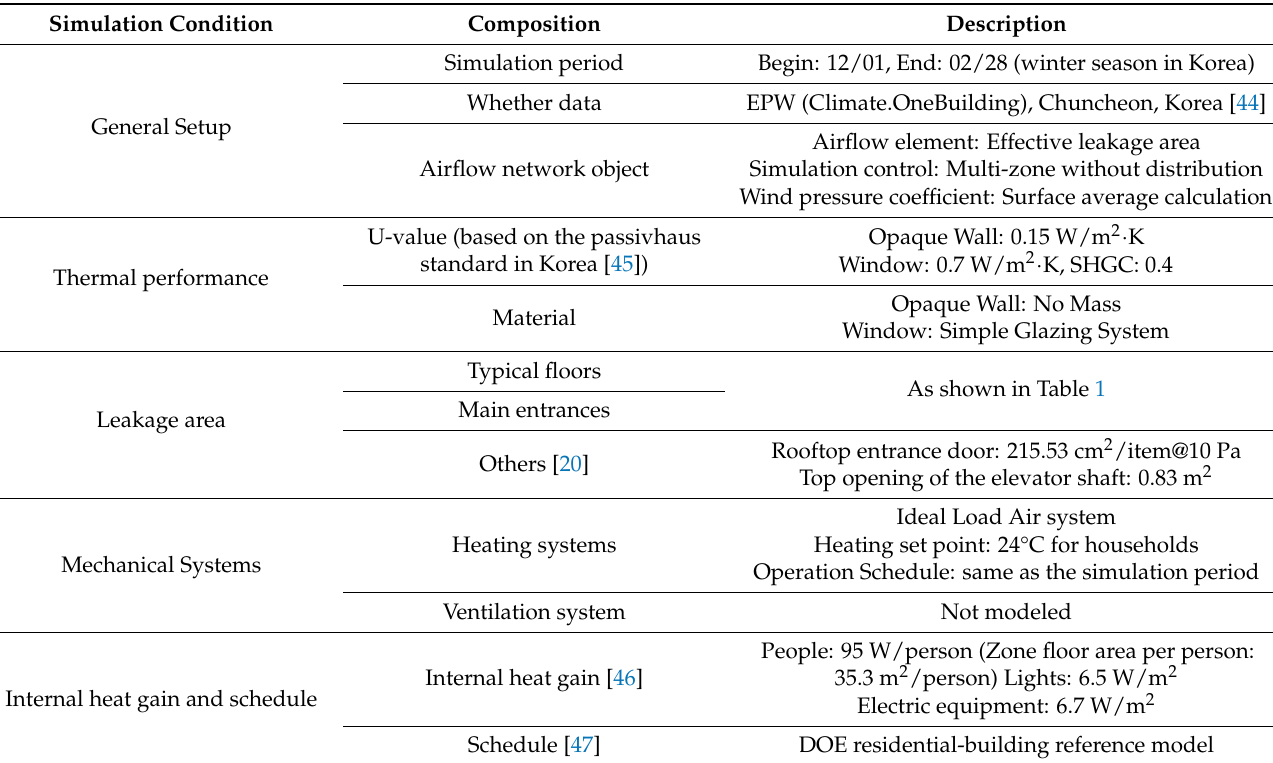
Table A2. EnergyPlus simulation conditions [29].